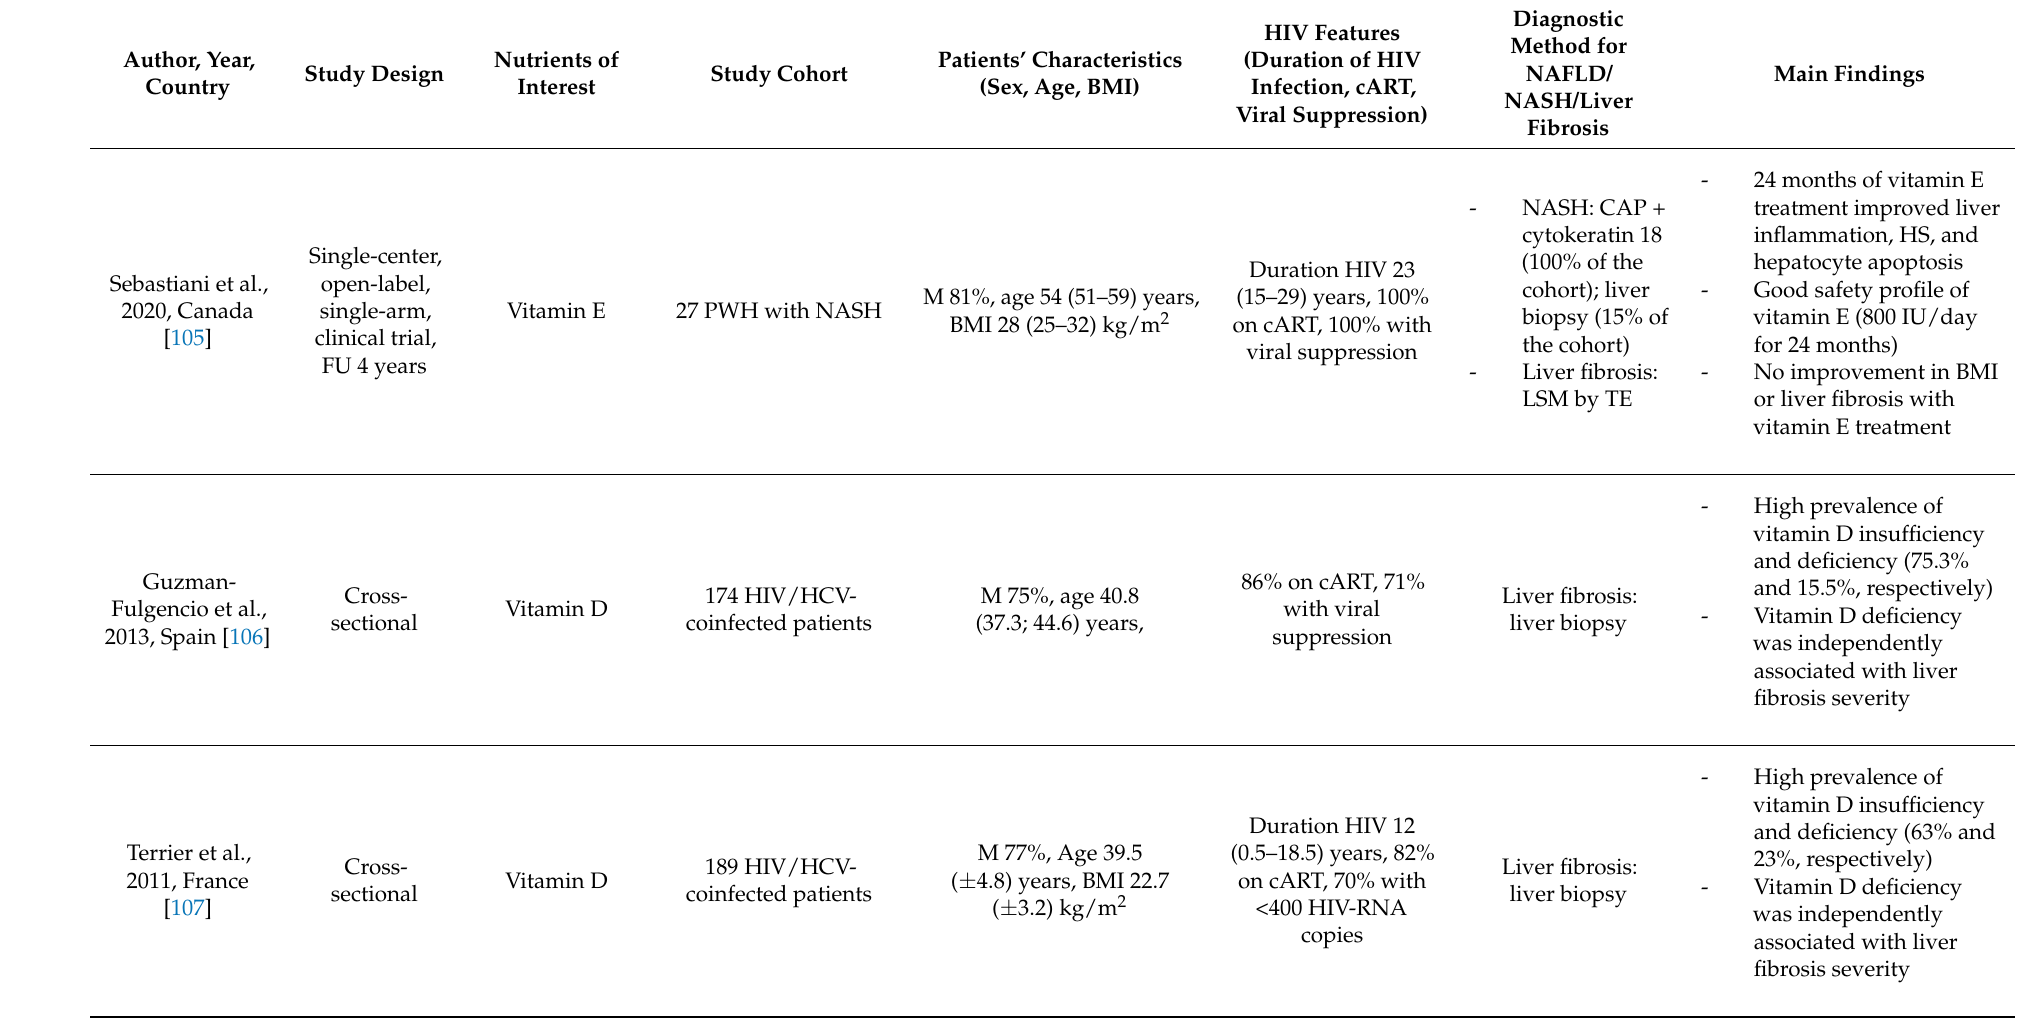
Table 2. Studies evaluating the role of micronutrients in hepatic steatosis and/or liver fibrosis in people with